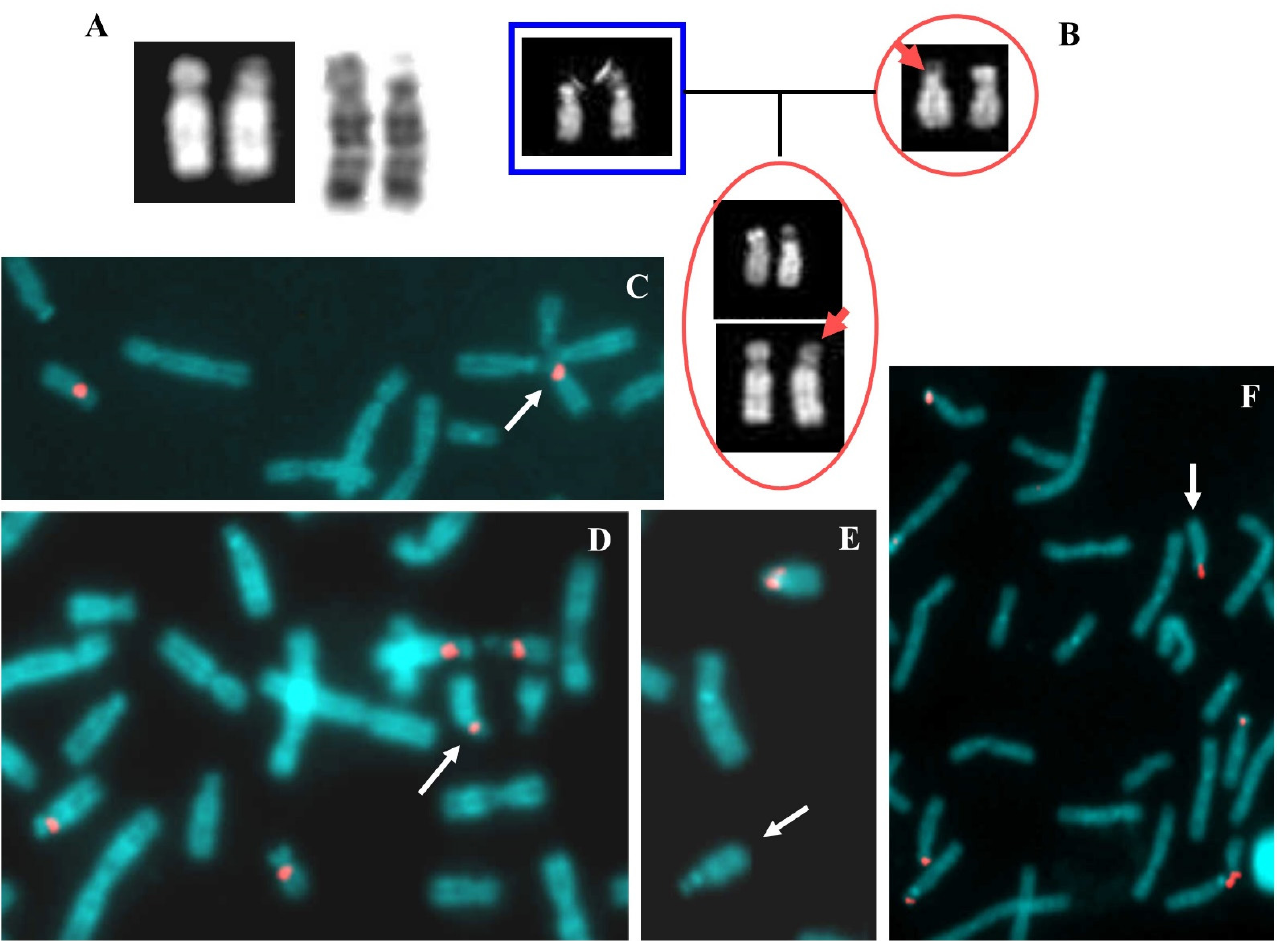
Figure 3. Case 3. ( A ) Chromosomes 18, QFQ ( left ) and GTG ( right ) banded, the 18ps is on the right of the couple. ( B ) Family tree showing the paternal chromosomes 22 on the left, those maternal on the right, and the daughter with 18ps together with 22 on the bottom. The arrows indicate the 22 maternal chromosome probably involved in the translocation. ( C ) Partial metaphase after FISH with probe D18Z1, the arrow indicates the 18ps in association with other acrocentric chromosomes of D and G groups. ( D ) Partial metaphase after FISH with probe D14Z1D22Z1, the arrow indicates the 18ps. ( E ) Normal chromosome 18 showing hybridization after FISH with probe RP11-48H7 (18p11.21) and the arrowed 18ps without signal of hybridization. ( F ) Partial metaphase after FISH with beta satellite probe, the arrow indicates the 18ps showing signal of